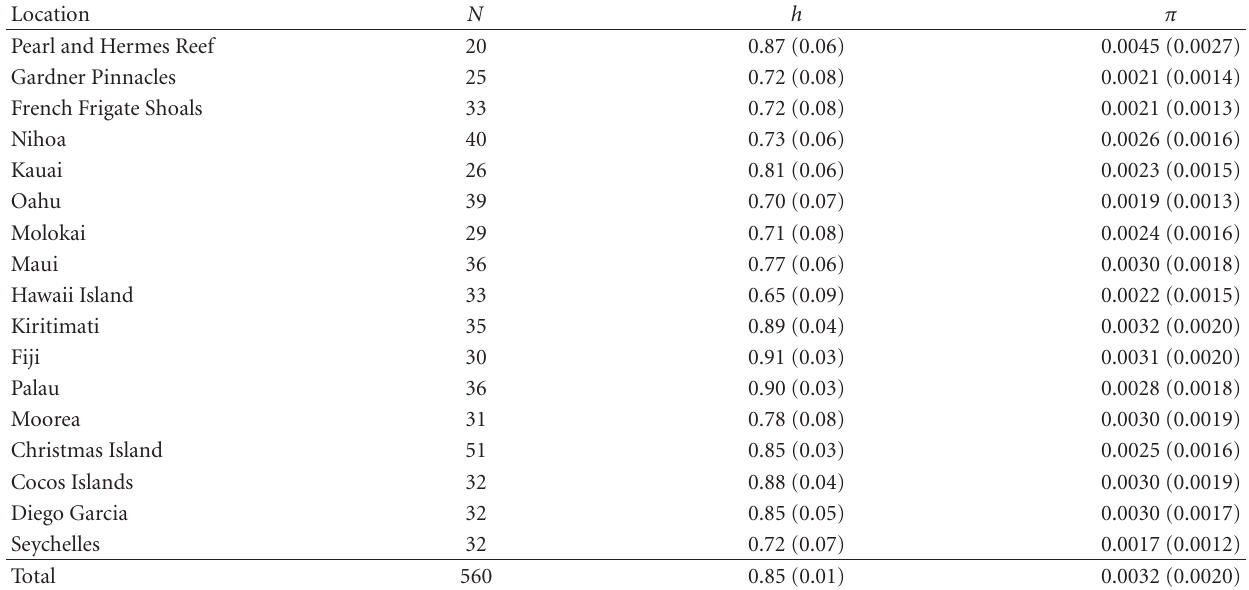
Table 1: Brown Surgeonfish collection sites with sample size, haplotype diversity ( h ), and nucleotide diversity ( π ) per sample and for the overall data set (Total), with standard deviations in